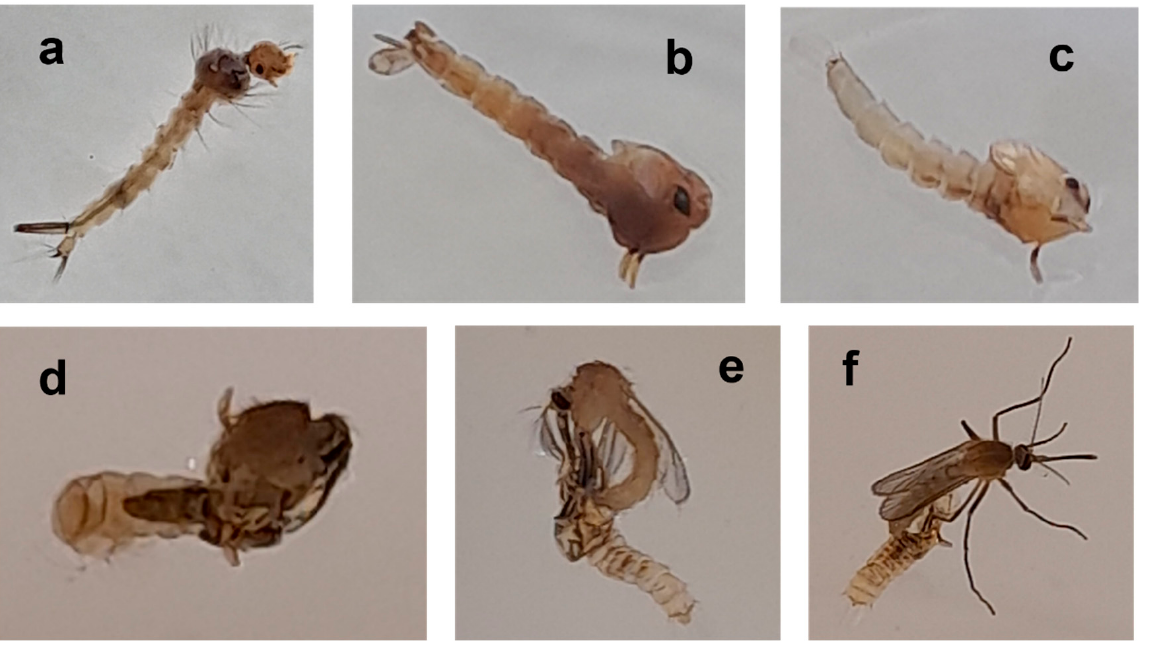
Figure 4. Dead elongated larva ( a ), larviform pupa ( b ), demelanized pupa ( c ), and failed adult emergence ( d – f ) after application of LC 50 concentrations of oregano oil and carvacrol on 3rd–4th instar larvae of Cx. pipiens biotype molestus .